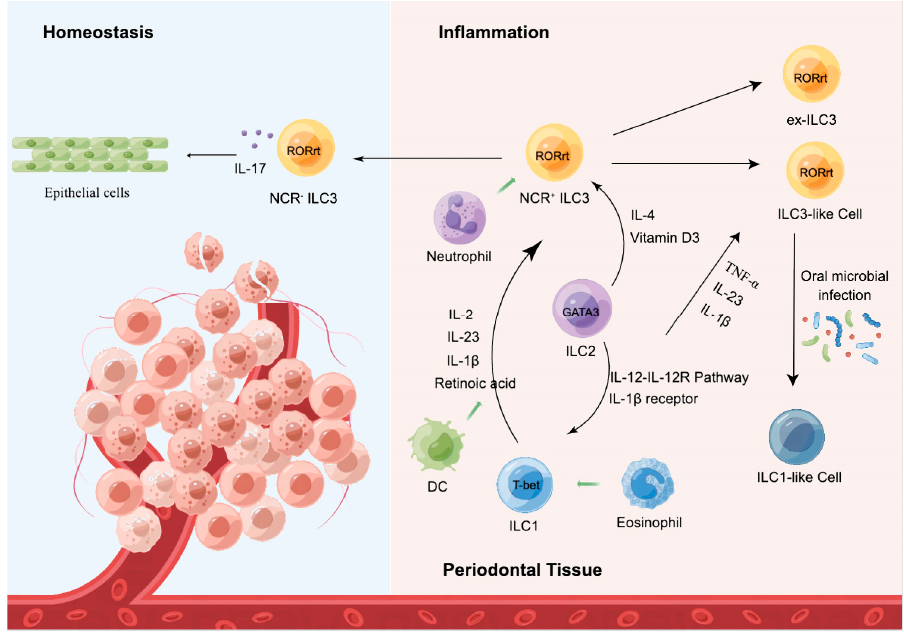
Figure 3. ILC subsets maintain periodontal homeostasis. At steady state, ILC subsets reside within the basal layers of the oral mucosal epithelium, contacting the basement membrane and slowly moving across the mucosal epithelium via contacting and squeezing between mucosal epithelial cells. At inflamed state, they generate cytokines and interact with other immune cells, such as neutrophils and eosinophils, to control ILCs’ plasticity during homeostasis via a complex network of transcription factors, resulting in the establishment of an antiviral/inflamed state of the mucosal epithelium.